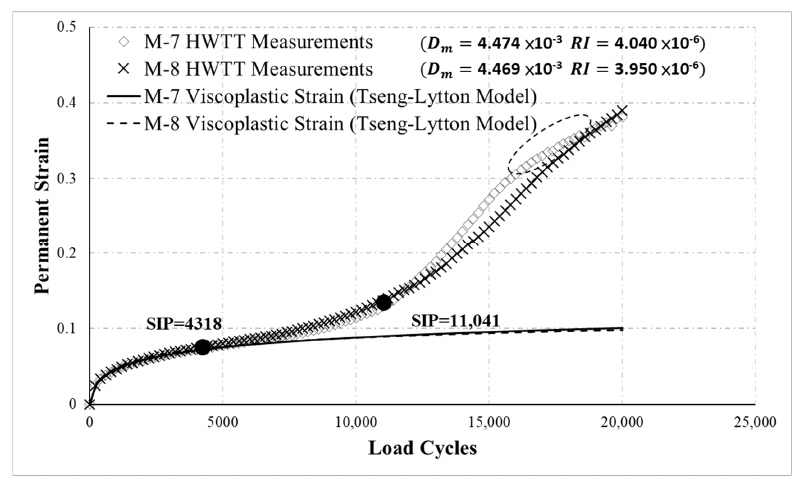
Figure 9. HWTT results for M-7 and M-8.